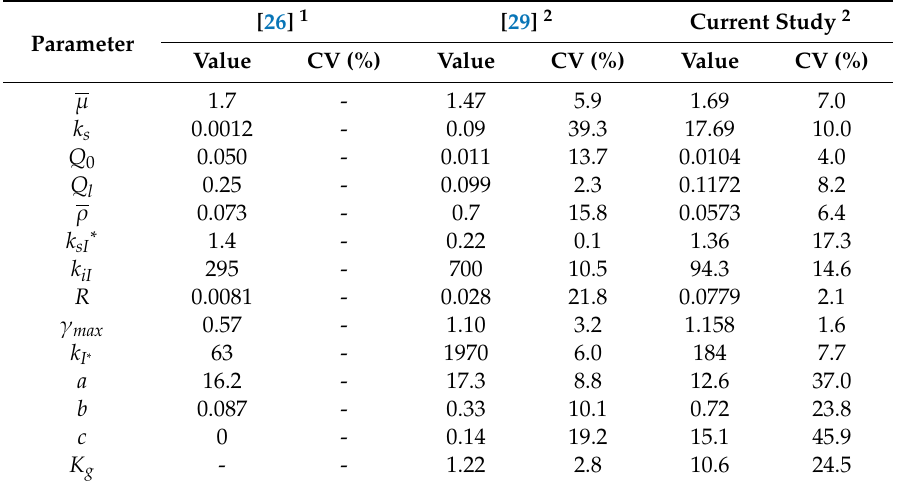
Table 5. Estimated values for model parameters (physical units are defined in Table A1).